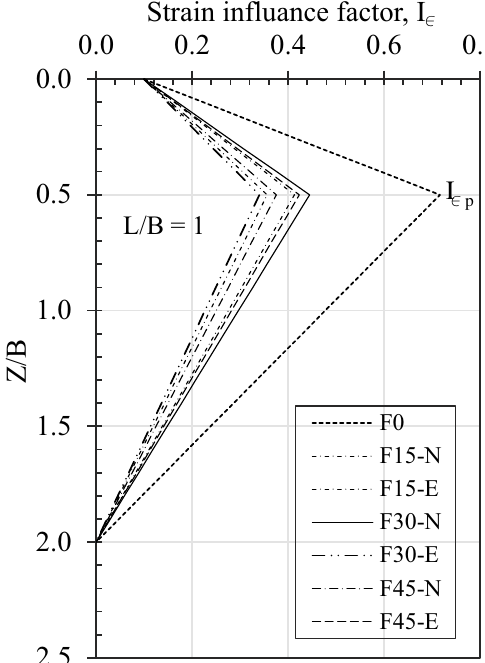
Fig. 18 Influence zone under the folded